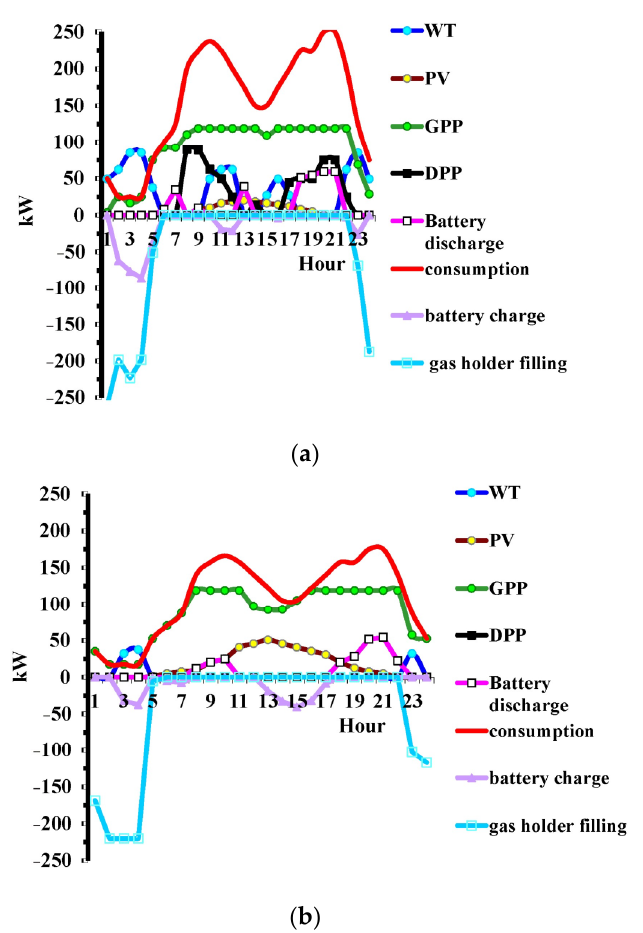
Figure 6. Capacities of energy sources under conditions favorable for RES (( a )—winter day, ( b )— summer day).